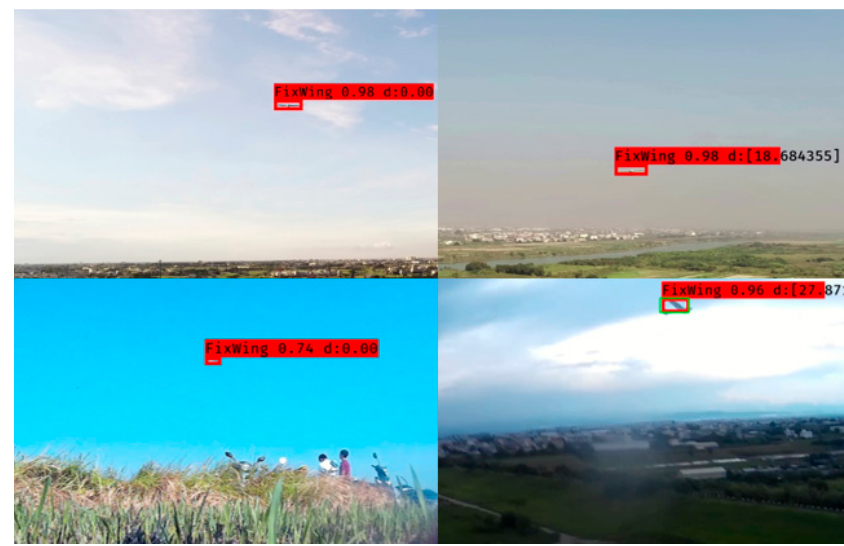
Figure 5. Detection results of the custom YOLOv3 detector from real images.